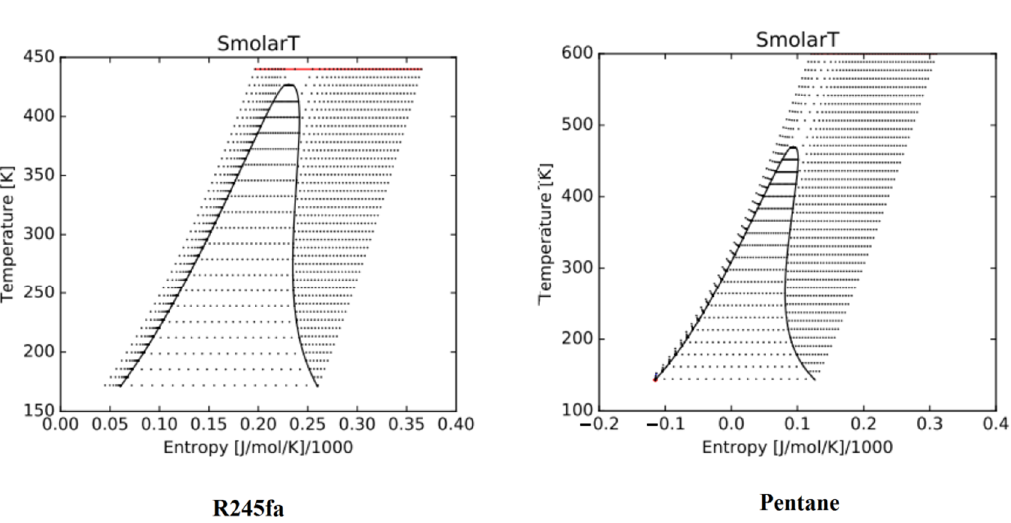
Figure 2. The temperature-entropy diagram of the two pure organic fluid R245fa (left) and Pentane (right).